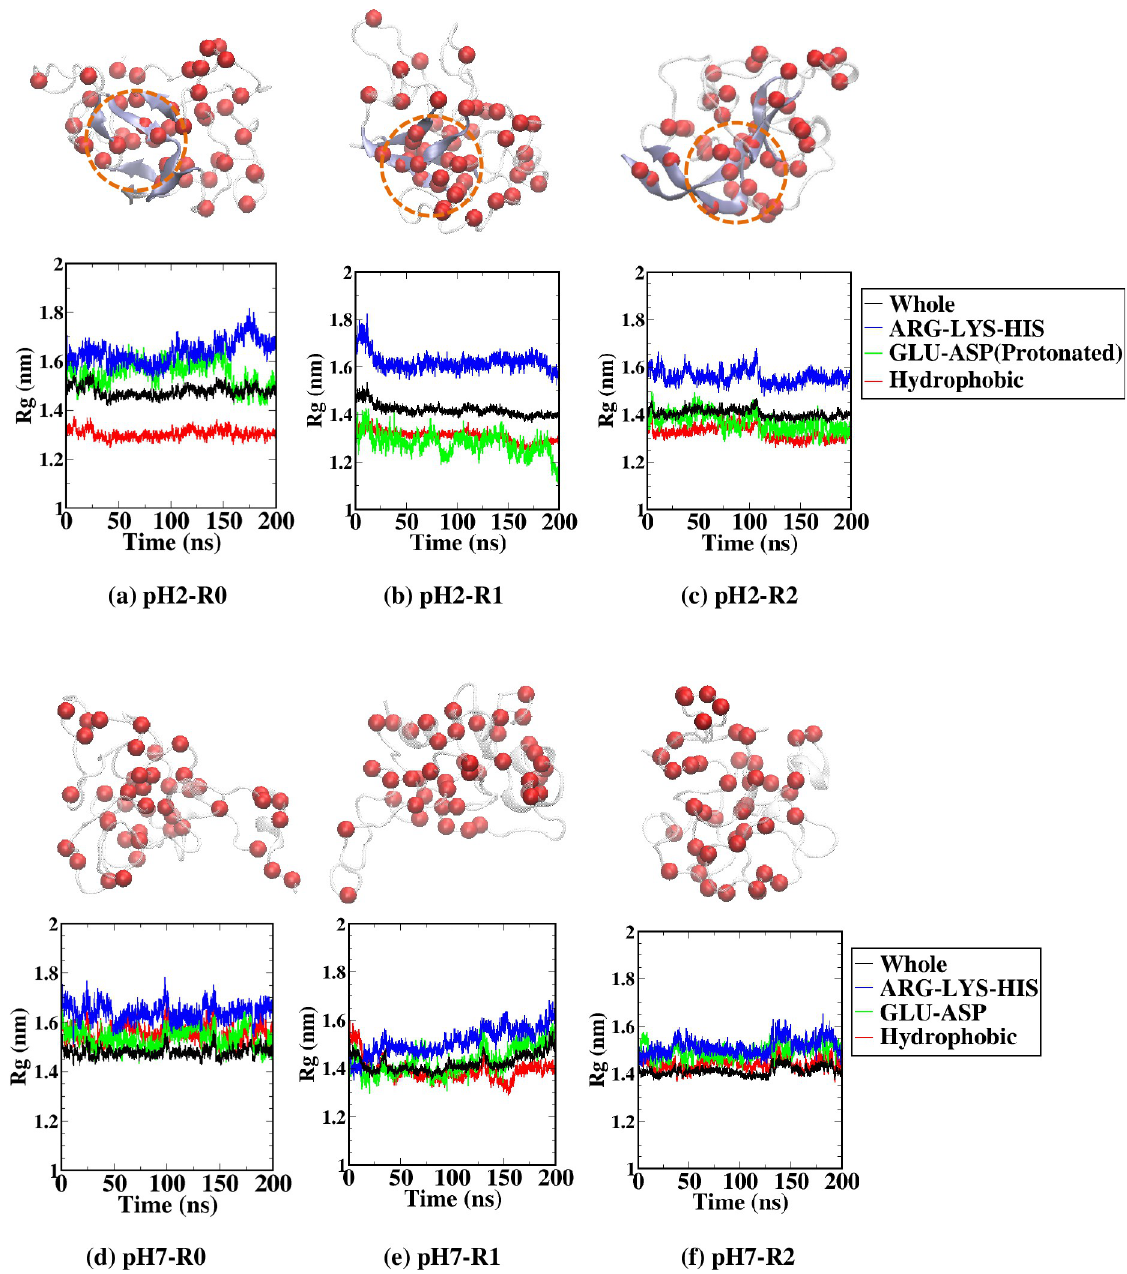
Fig 4. Radius of gyration (Rg) calculated for the groups of whole HEWL structure (black), positively-charged residues (ARG-LYS-HIS; blue), negatively-charged residues (GLU-ASP; green), and hydrophobic residues (red) along all three 333-K simulation replicas of HEWL at (a-c) pH 2 and (d-f) pH 7. The negatively-charged residues were protonated at pH 2. Final snapshots highlighting C-alpha atoms of hydrophobic residues (red sphere) were also shown. Dash circles indicated the cluster of hydrophobic residues around the beta-strand regions at pH